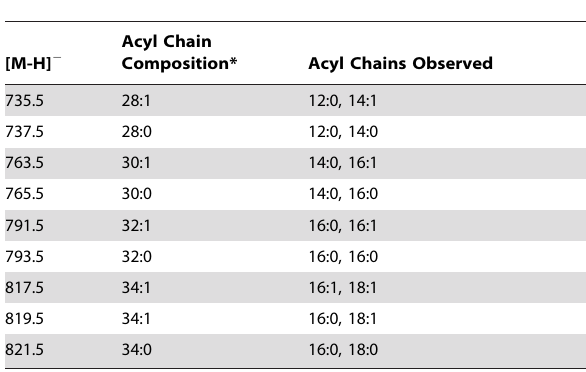
Table 6. SQDG species identified in FLAp1AB lipid extracts.